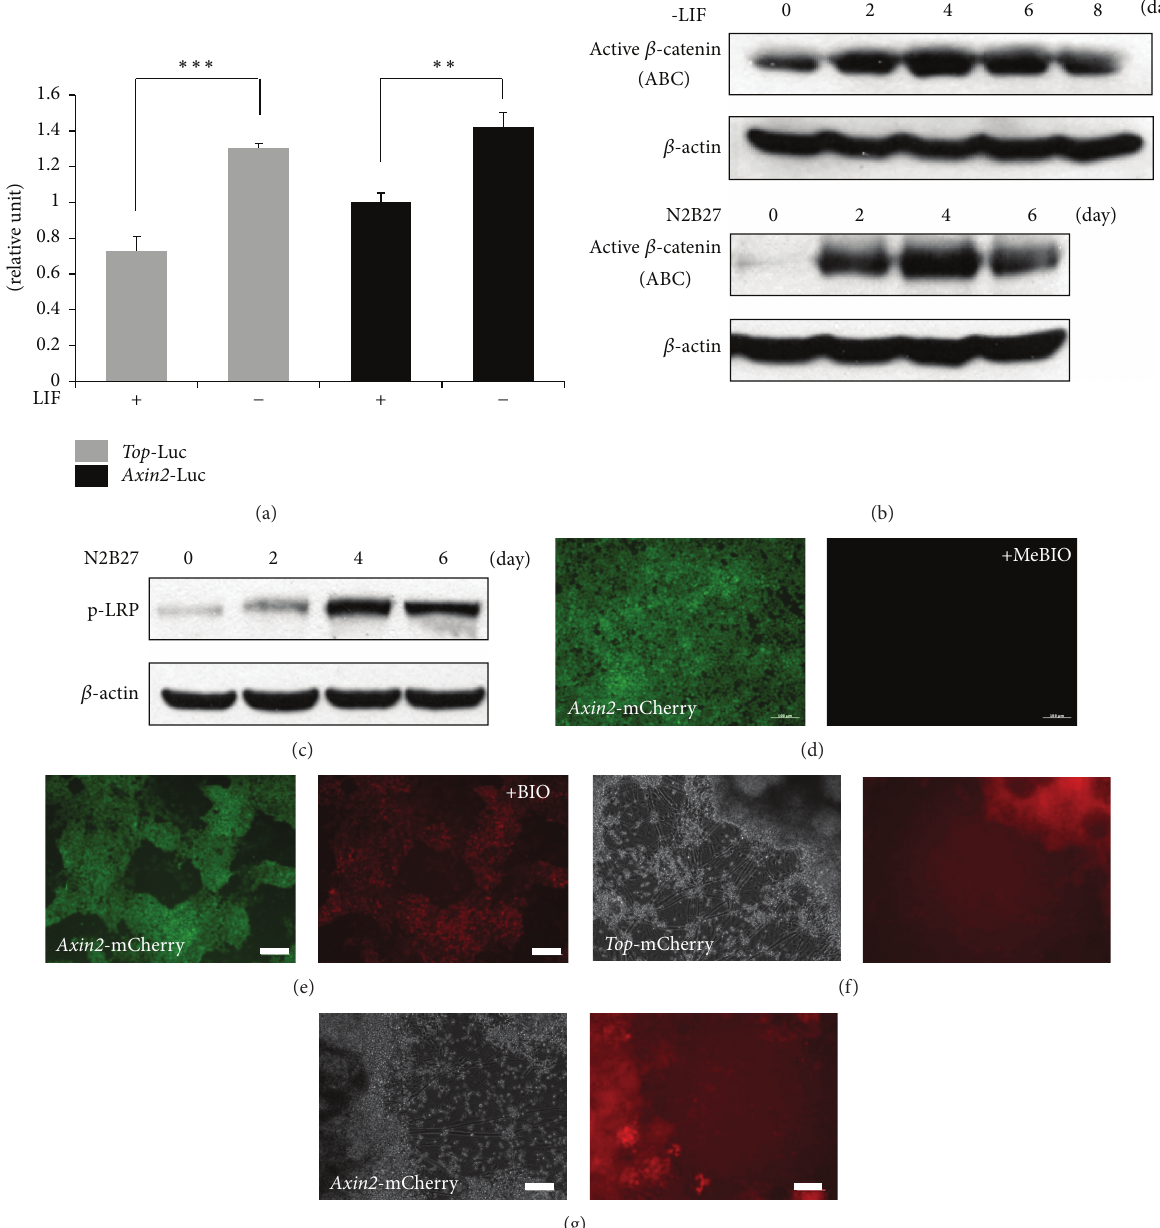
Figure 2: Increase in canonical Wnt signaling during neural differentiation. (a) Both TOP and Axin2 promoter luciferase activities in E14 ES cells were induced at 48h after LIF removal. (b) Western blot analysis using ABC (active 𝛽 -catenin) and 𝛽 -actin antibodies. Active 𝛽 -catenin level was the highest on day 4 of neural differentiation. (c) p-LRP level was the highest on day 4 of neural differentiation. (d)-(e) In Oct4- Gip/Ax2P-mCherry cells, only GFP expression was detected. mCherry expression was increased after 24 h addition of BIO (0.75 𝜇 M). (f)-(g) mCherry expression increased in the neural precursor region of TOP-mCherry ((d) and (e)) and Ax2 p-mCherry ((f) and (g)) stable cell lines during neuronal differentiation. Stable cell lines were cultured in N2B27 medium for 14 days. Scale bars, 100 𝜇